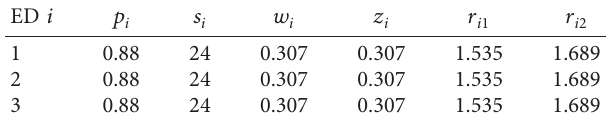
Table 2: Optimal variable values for each ED.